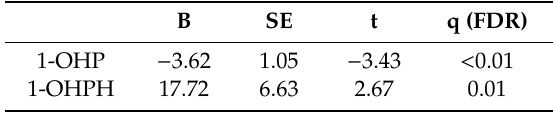
Table 6. Multiple linear regression analysis of H19